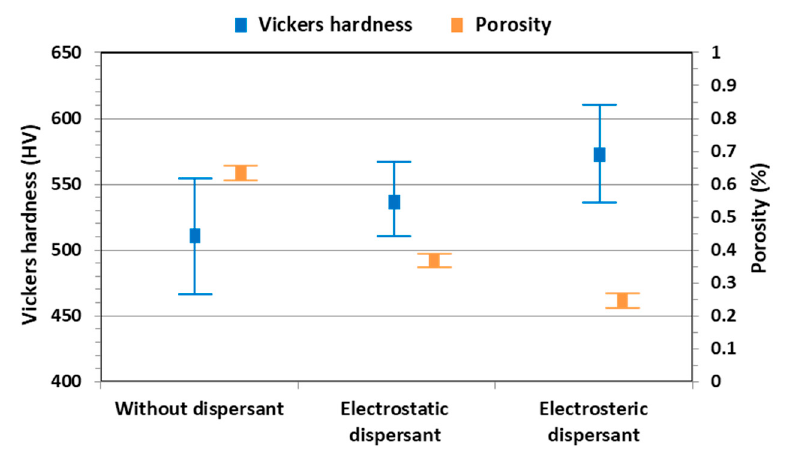
Figure 10. Vickers hardness and porosity of YOF coatings deposited with the electrostatically, electrosterically stabilized Y 5 O 4 F 7 suspensions, and Y 5 O 4 F 7 suspension without dispersant.